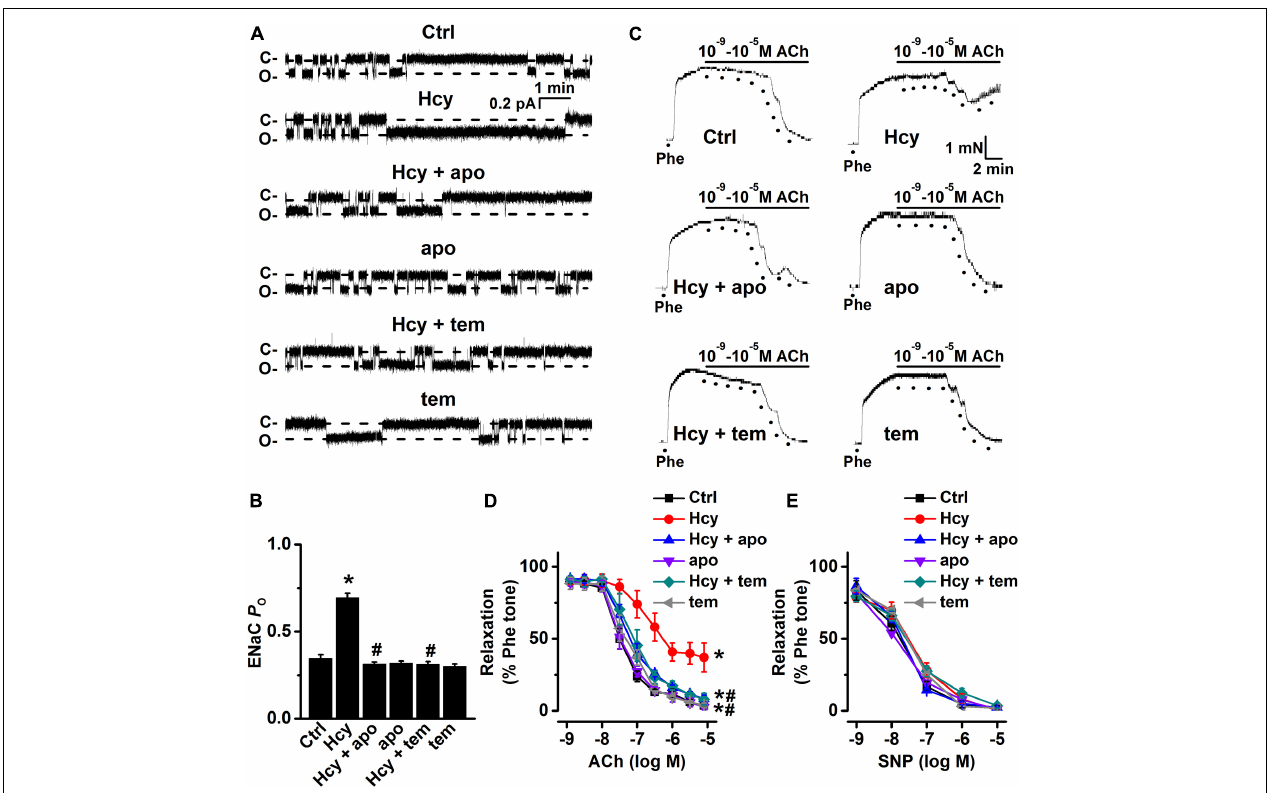
FIGURE 4 | Inhibition of ROS attenuates Hcy-induced increase in ENaC activity and impairment of EDR in mouse aorta. (A) Representative ENaC single-channel currents were recorded in endothelial cells from split-open aorta either under control conditions or treated with 100 µ M Hcy, 100 µ M Hcy plus 100 µ M apocynin (apo), 100 µ M apo alone, 100 µ M Hcy plus 100 µ M TEMPOL (tem), or 100 µ M TEMPOL alone for 6 h, respectively. (B) Summarized ENaC P O obtained from recordings as shown in (A) . Data are means ± SEM of six mice. * P < 0.05 vs. ctrl; # P < 0.05 vs. Hcy. (C) Representative traces obtained from wire myograph assays under each indicated condition and (D) summarized data of ACh-induced relaxation under each indicated condition. The first dot indicates the application of 10 − 9 M ACh to the 1 µ M Phe precontracted arterial rings, whereas the following dots indicate ACh concentrations gradually increasing from 10 − 8 . 5 to 10 − 5 M. Data are means ± SEM of six mice. * P < 0.05 vs. ctrl; # P < 0.05 vs. Hcy. (E) Summary of artery relaxation induced by different doses of SNP increasing from 10 − 9 to 10 − 5 M in aorta from each indicated